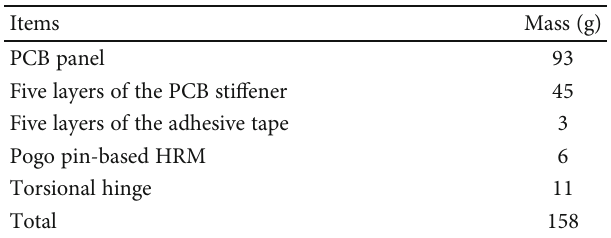
Figure 1: Con fi guration of the highly-damped deployable solar panel module with pogo pin-based HRM: (a) stowed and (b) deployed. Table 1: Speci fi cation of the 3M ™ 966 adhesive transfer tape [27]. Item